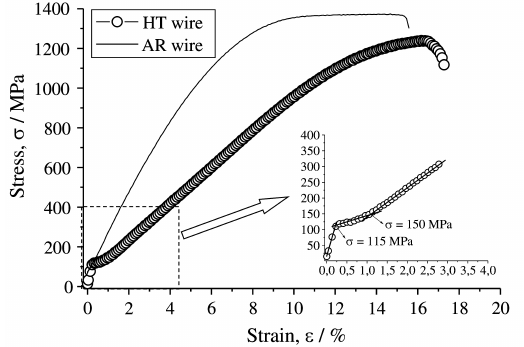
Figure 2. Stress-Strain curves of the as-received (AR) and heat-treated (HT) Ti-Ni-Cu shape memory wires at 10